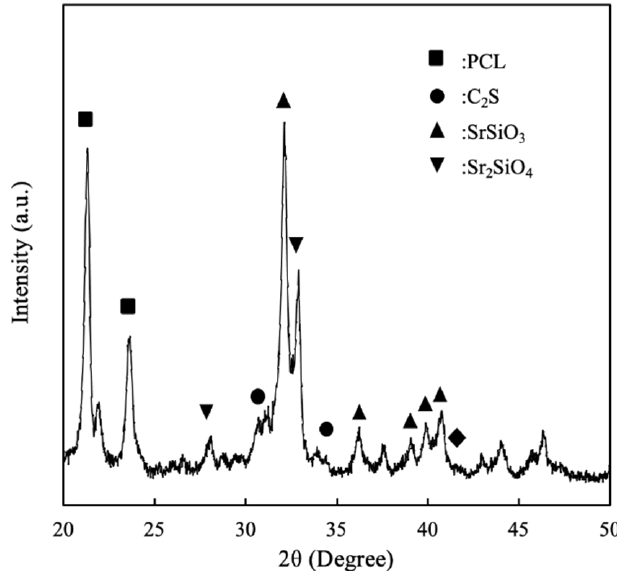
Figure 2. X-ray diffractometry (XRD) of SrCS scaffold.